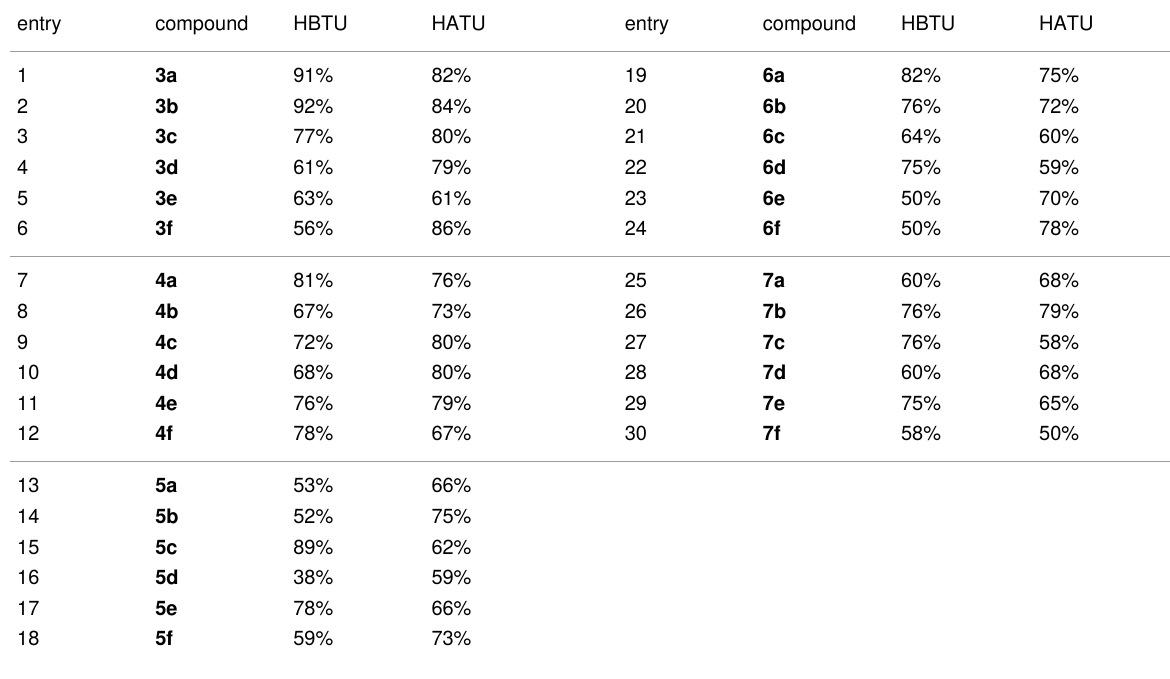
Table 1: Yields of the peptide coupling reactions and comparison of HBTU and HATU. entry